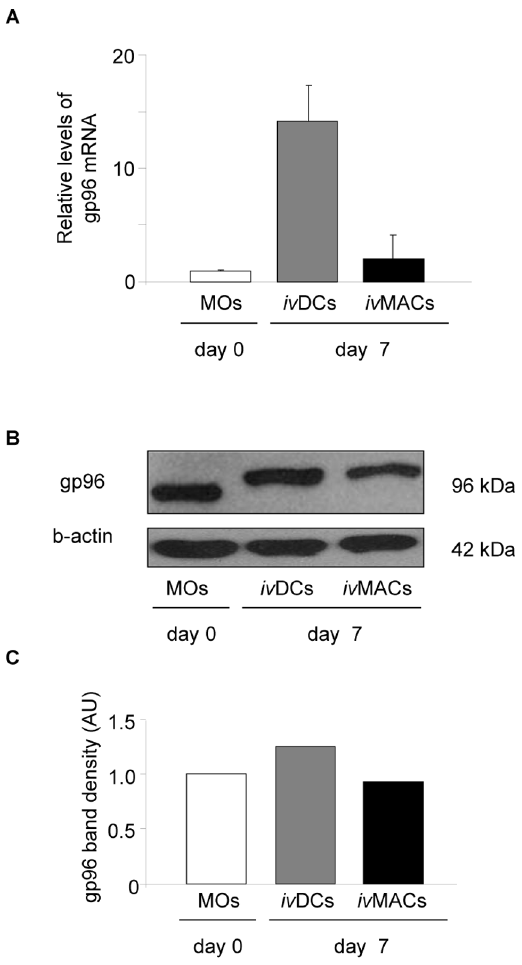
Figure 2. Regulation of gp96 expression during differentiation of MOs to i. v.DCs and i. v.MACs. (A) Relative mRNA levels of gp96 (vs. GAPDH) by RT-PCR. Results are representative for three experiments in total. A typical result is shown where the basal level in MOs is set as a reference. Error bars represent the standard deviation of a single experiment measured in triplicate. (B) Western blot analysis of gp96. (C) Densitometric analysis. AU: arbitrary units, kDa: Kilodalton.